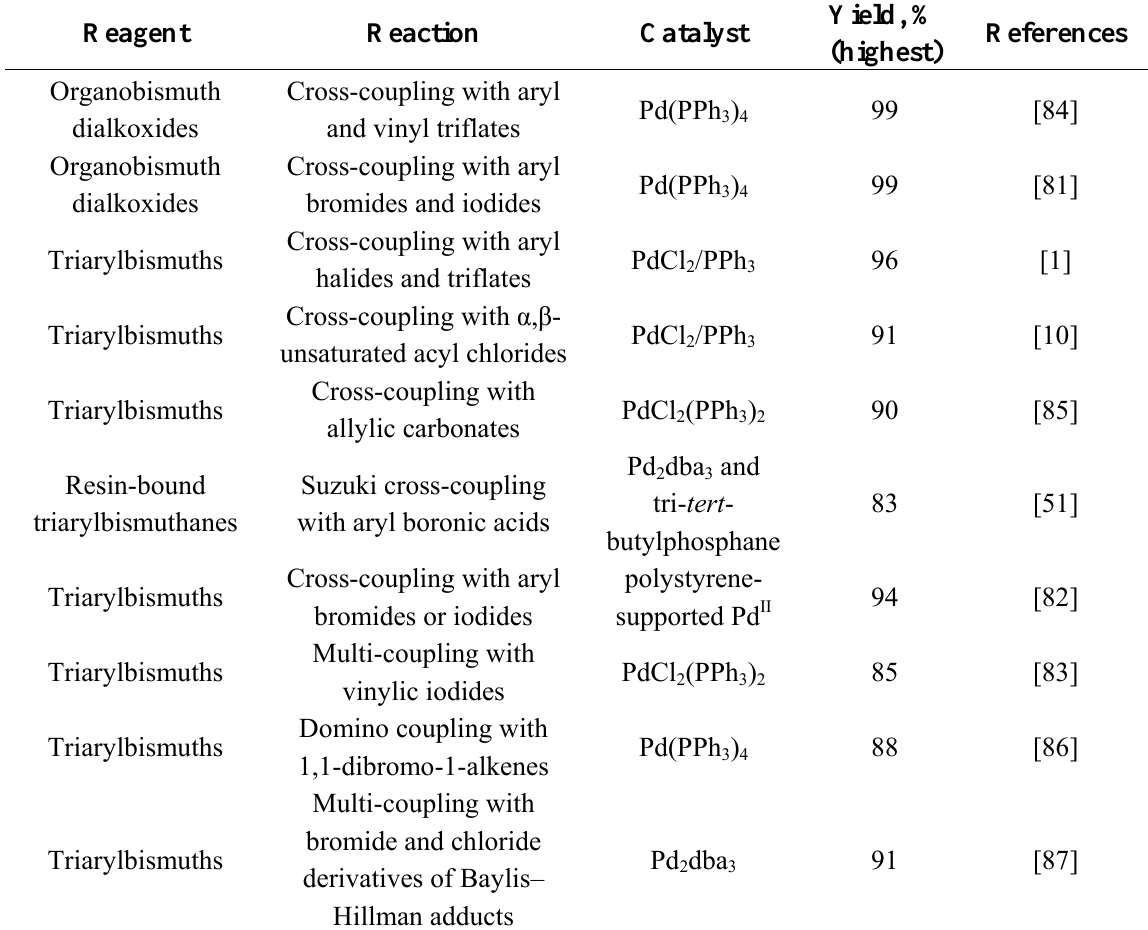
Table 2. Cross-coupling reactions of organobismuth reagents with electrophilic